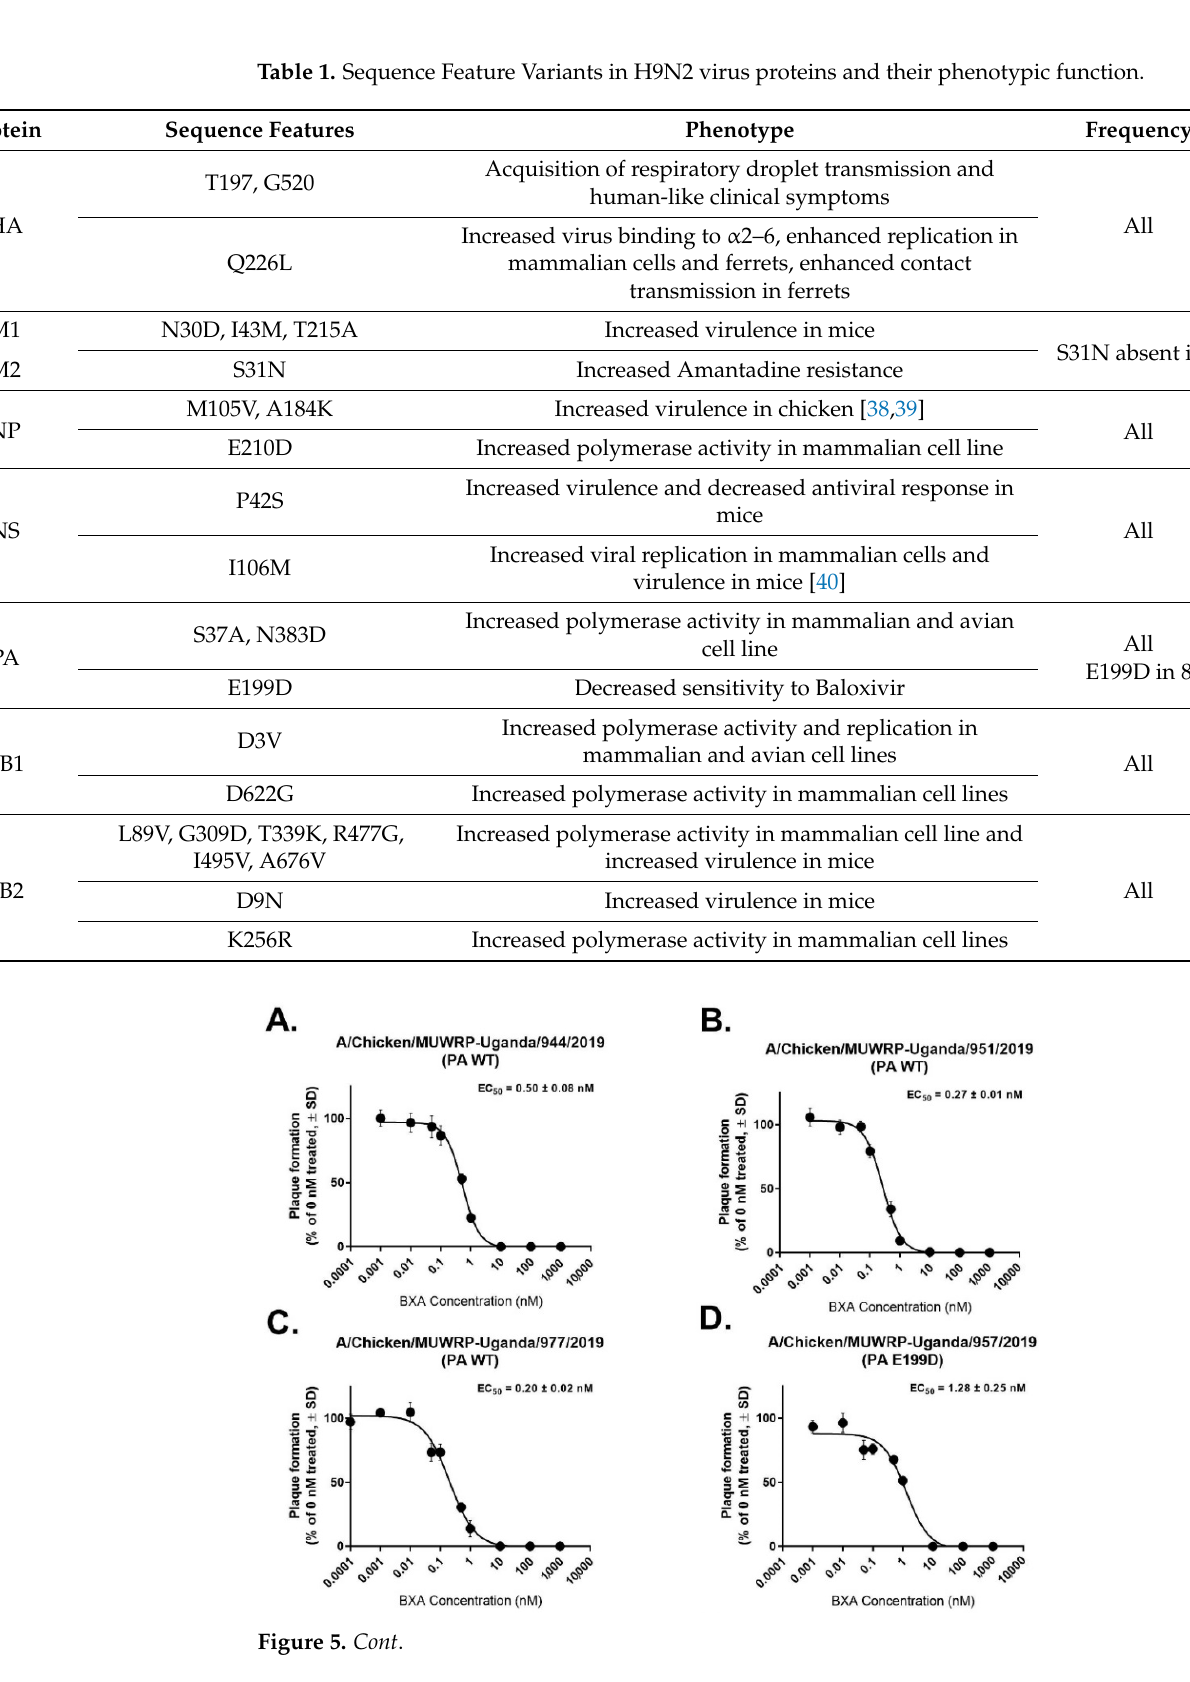
Figure 5. BXA Susceptibility of H9N2 viruses from Uganda containing the PA E199D substitution. The wild type (WT) viruses in A, B and C have EC50s ranging from 0.2-0.5nM while those with the ED substitution E, F and G have increased EC50s of 0.74-0.83nM. D. shows a virus which had both PA F105L+E199D had the highest EC50 of 1.28nM, which suggests a synergistic effect. Data is representative of an average of three independent dose-response curves. 3.6. Antigenic Analysis Selected viruses were evaluated for their antigenic properties using a panel of reference antigens and antisera. The selected viruses were antigenically similar to each other and reacted within four-fold to post-infection antiserum raised against A/Oman/2747/2019 IDCDC-RG66A, a human H9N2 virus (Table 2).